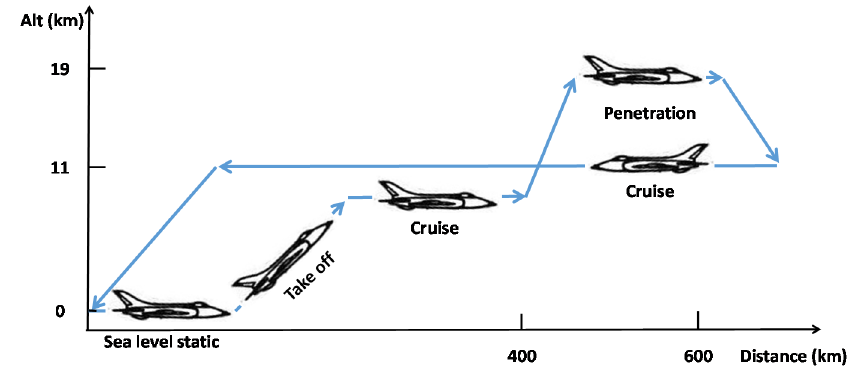
Figure 7. Flight mission profile.